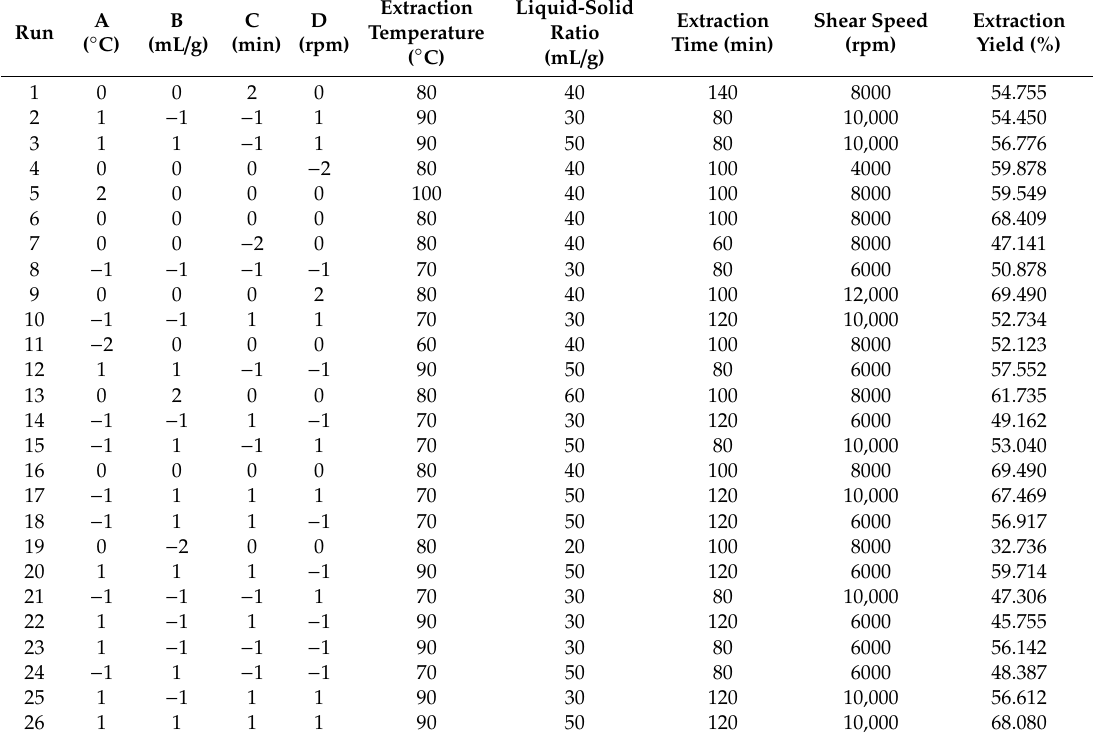
Table 1. A CCD matrix of the four variables in coded units and response values for the extraction yield of BS